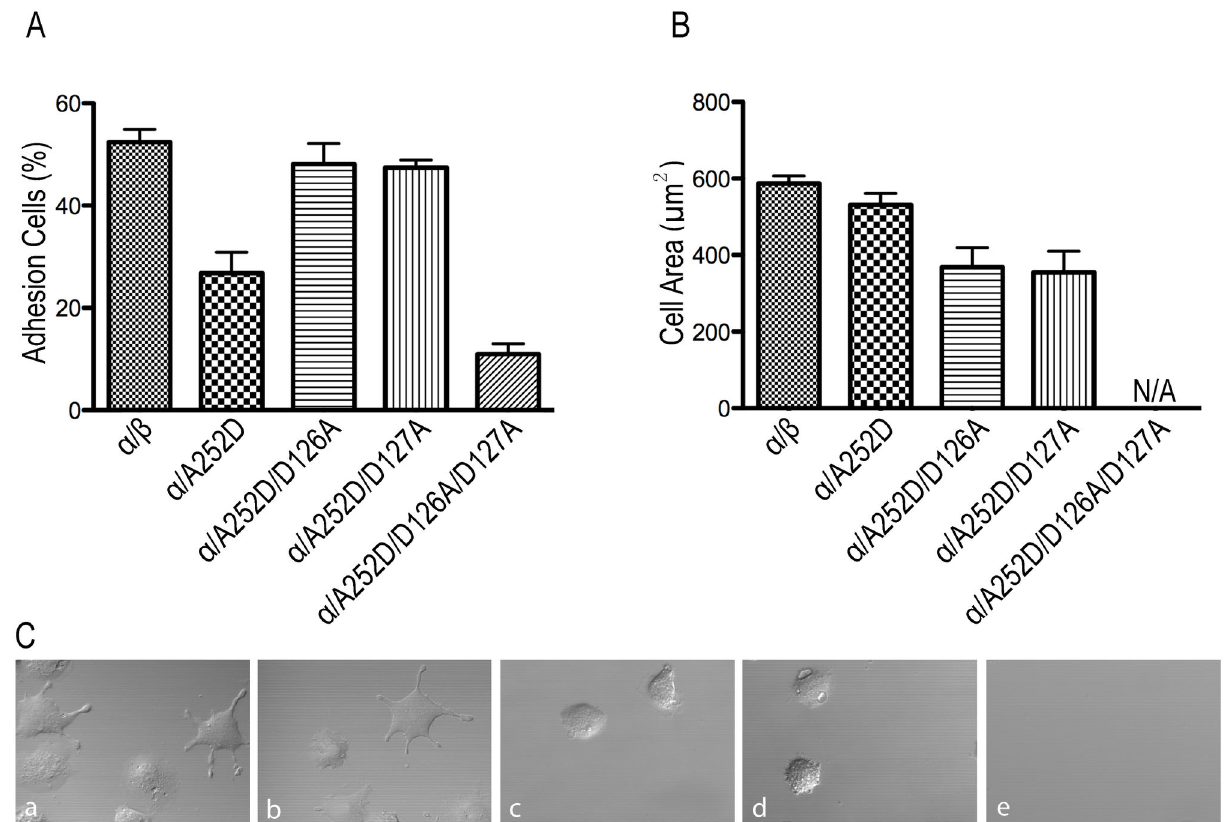
Figure 4. Cell adhesion and spreading. A. Adhesion of HEK293T transfectants to surfaces coated with 20 µg/mL fibrinogen. The amount of bound cells was determined by measuring LDH activity as described in Materials and Methods. Data are representative of three independent experiments, each in triplicate. Error bars are SD. B. Quantification of the areas of adhering/spreading cells as described in Materials and Methods. C. DIC images of HEK293T transfectants after adhering to immobilized fibrinogen at 37°C.